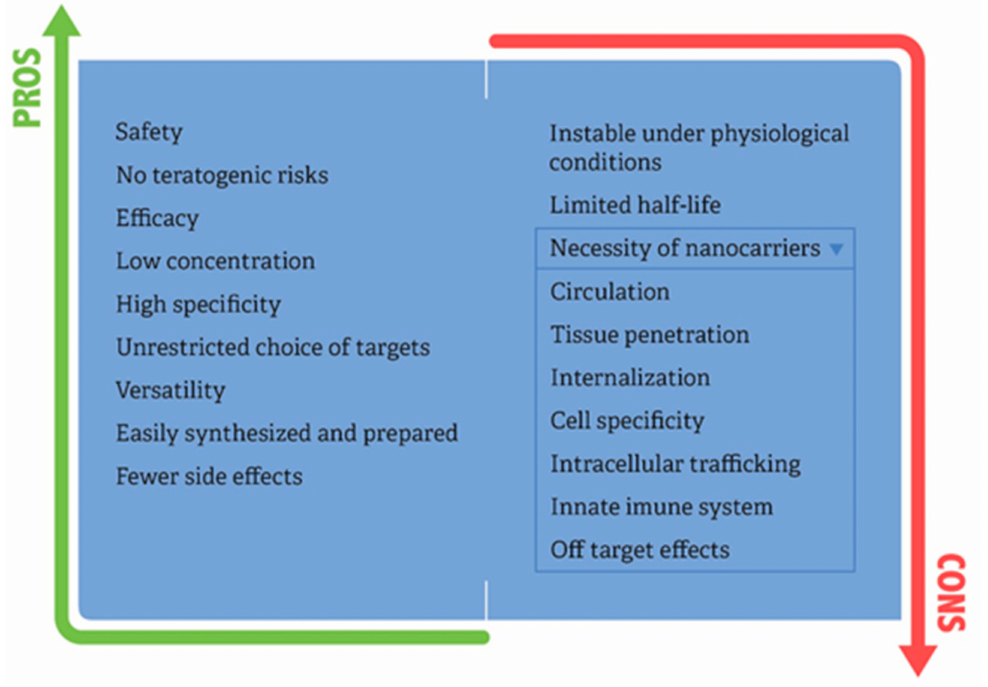
Figure 3. Pros and cons for the broader use of siRNAs into